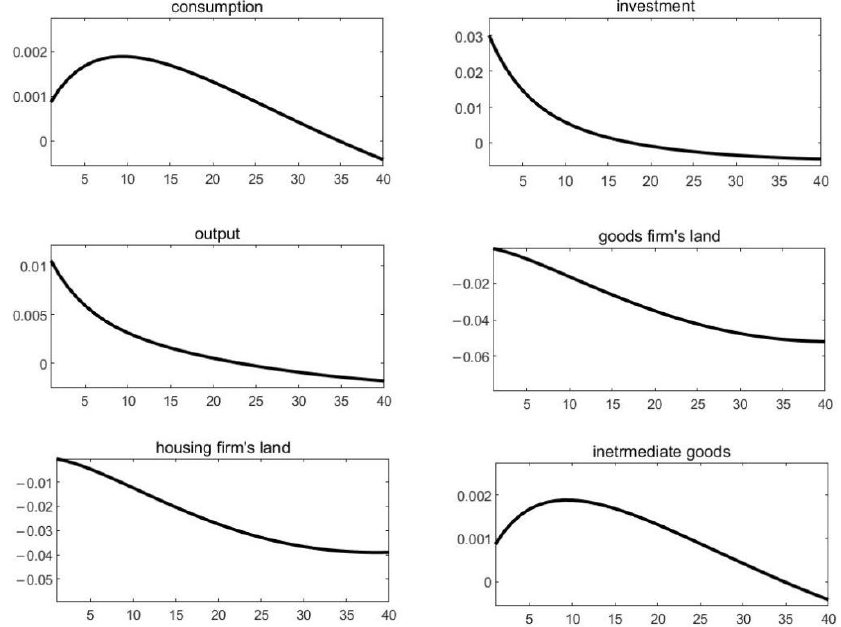
Figure 8. Impulse responses to a positive (one standard deviation) TFP shock in social planner’s problem.